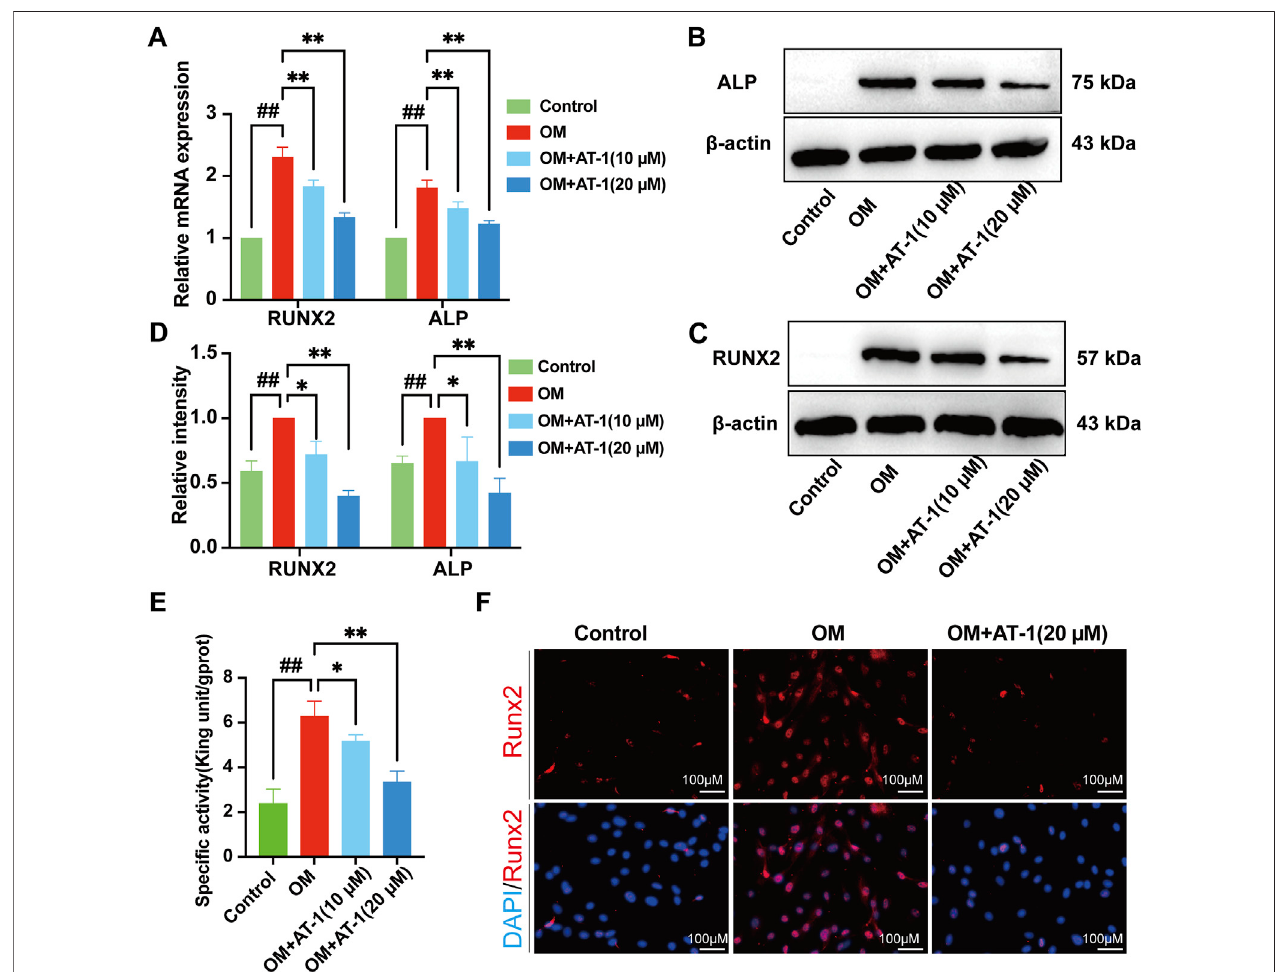
FIGURE2| EffectofAT-1onOM-inducedcalci fi c-relatedgeneandproteinexpressioninVICs. (A) VICswerestimulatedwithOMandthentreatedornotwithAT-1 for 48 h. The mRNA RUNX2 and ALP expression levels were analyzed by quantitative real-time polymerase chain reaction (qRT-PCR). (B, C) VICs were stimulated with OMandthentreatedornotwithAT-1andAGPfor48 handtheexpressionlevelsofRUNX2andALPproteinweredetectedbyWesternblotting. (D) Statisticalanalysisof Runx2 and ALP protein expression. (E) The ALP activity of the VICs was measured using the ALP biochemical kit. (F) The expression of RUNX2 in VICs was evaluated at 48 h by immuno fl uorescence. * p < 0.05, ** p < 0.01 indicated a signi fi cant difference compared to the control group and # p < 0.05, ## p < 0.01 indicated a signi fi cant difference compared to the OM group, n =